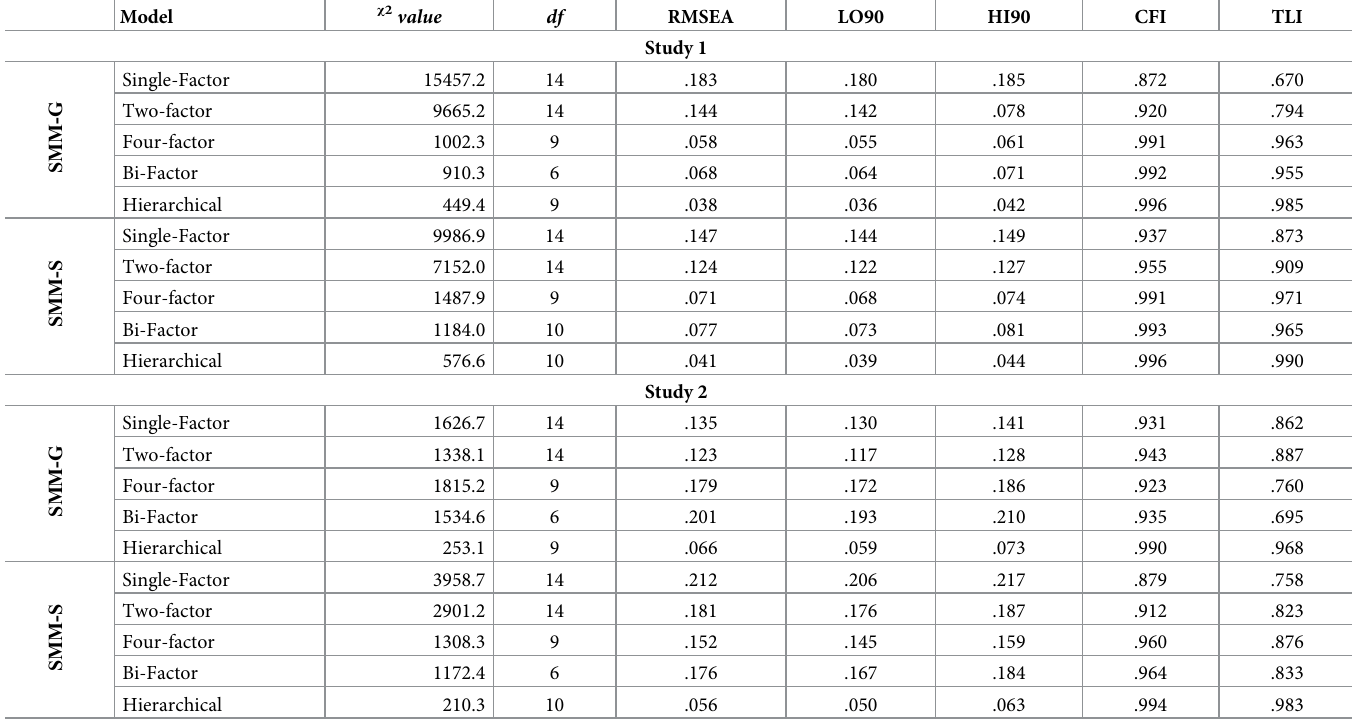
Table 5. CFA fit indexes of the SMM factor structure models (Study 1 and Study 2).